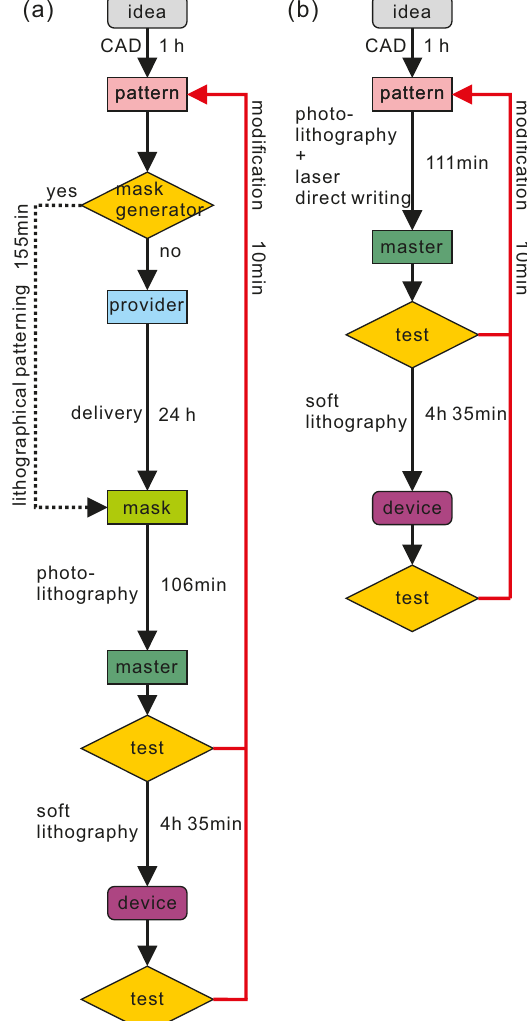
Figure 5. The process comparison of soft lithography with this technique. ( a ) Soft lithography; and ( b ) this prototyping technique.